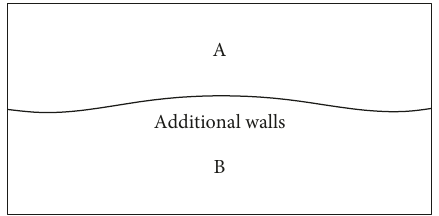
Figure 7: Schematic of the numerical